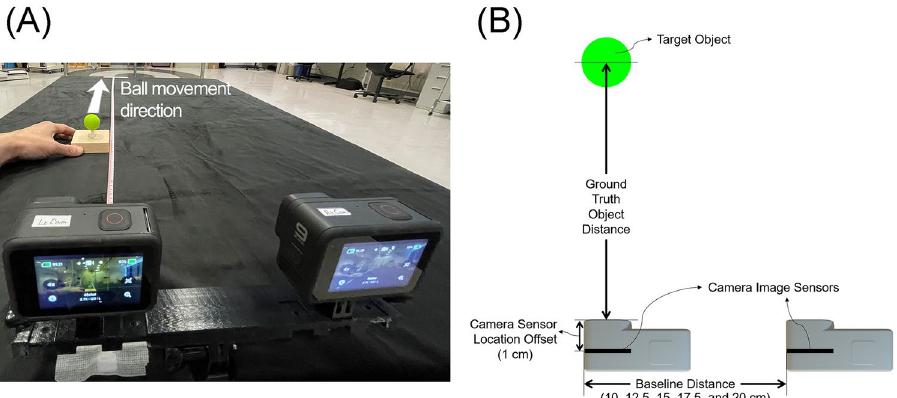
Figure 1. Experiment 1 setup. ( A ) A picture of the experiment’s workspace. The table was draped with black cloth. A tape measure was placed on the middle of the table. Each 0.1 m was marked from 0.3 to 1 m. The stereo camera system was placed on the table. The target object is 0.3 m away in front of the left camera. The object was then manually moved in the z (anterior–posterior) direction at 0.1 m increments to a distance of 1 m from the camera. The video was taken at a frame rate of 24 frames per second (fps). ( B ) The experiment workspace from superior view. Two cameras were set apart at each baseline distance for each trial. In the data analysis, the camera image sensor offset (1 cm) was added to the estimated distance between the camera and the